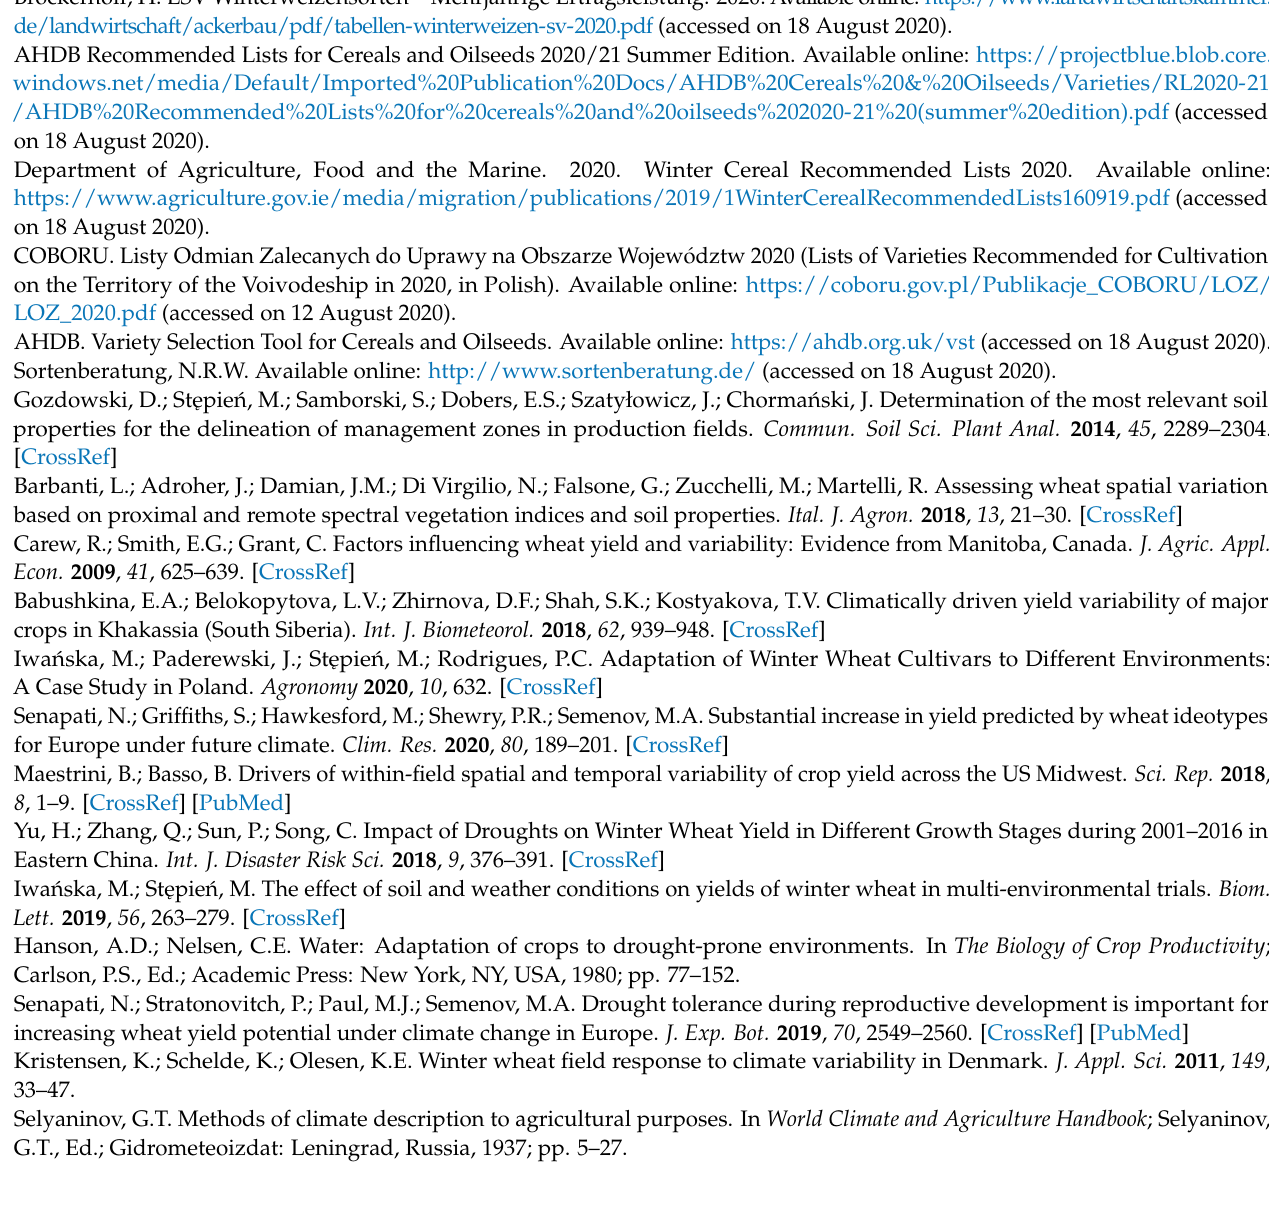
Table S5: Weather factors during the period between the 1st of April and the 20th of July in the years of the